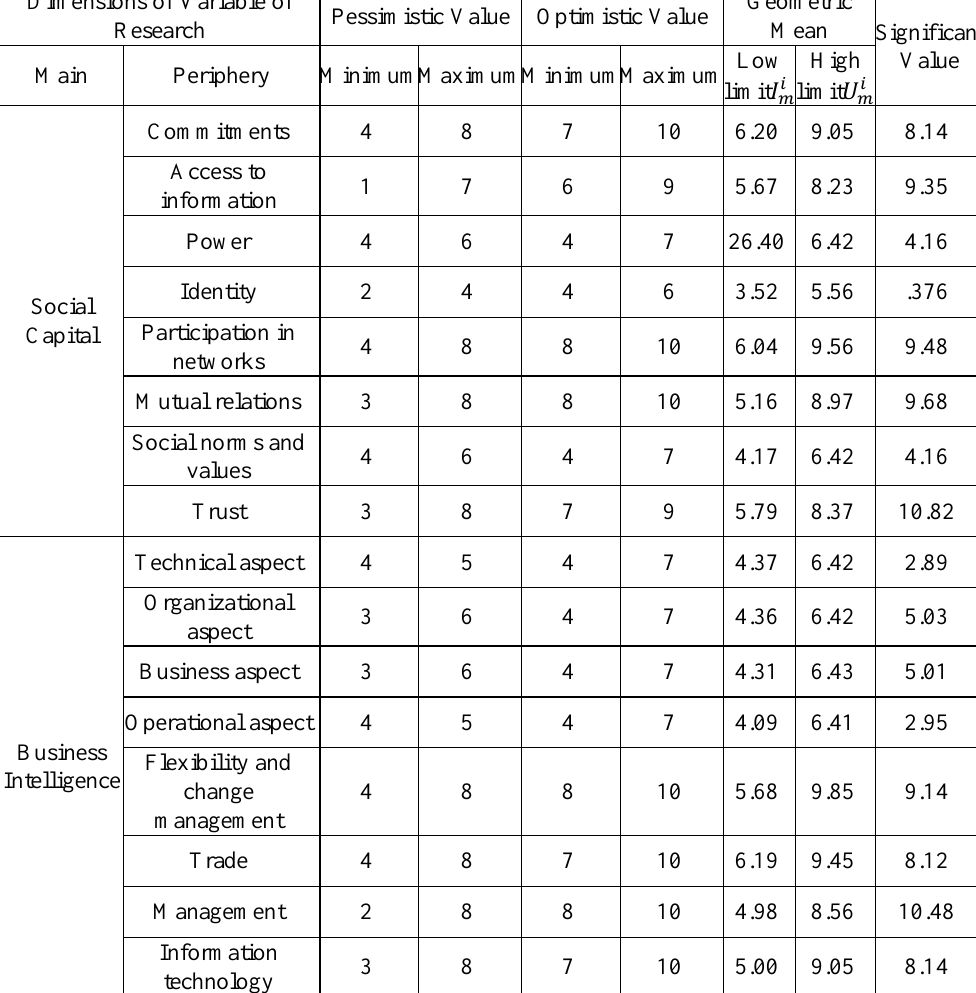
Table. 1. Selection of the Most Suitable Criteria Based on Delphi Fuzzy Method Dimensions of Variable of